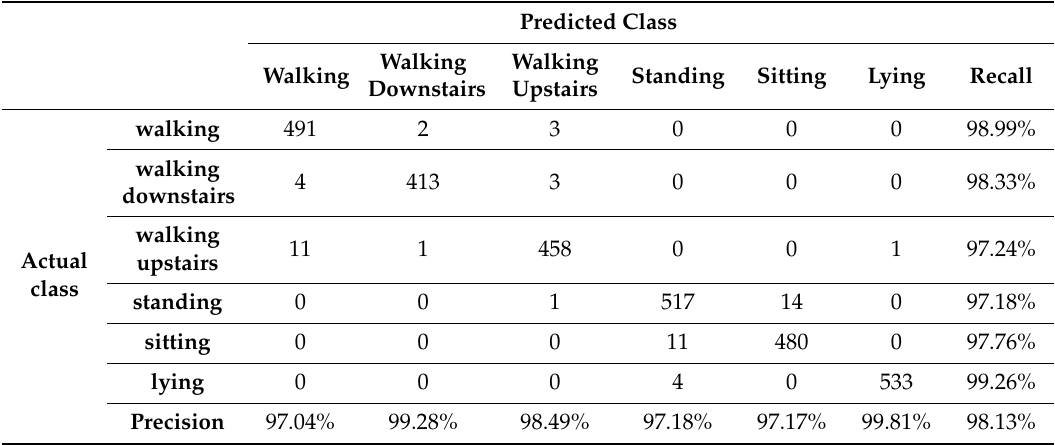
Table 5. Confusion matrix of classification for six basic